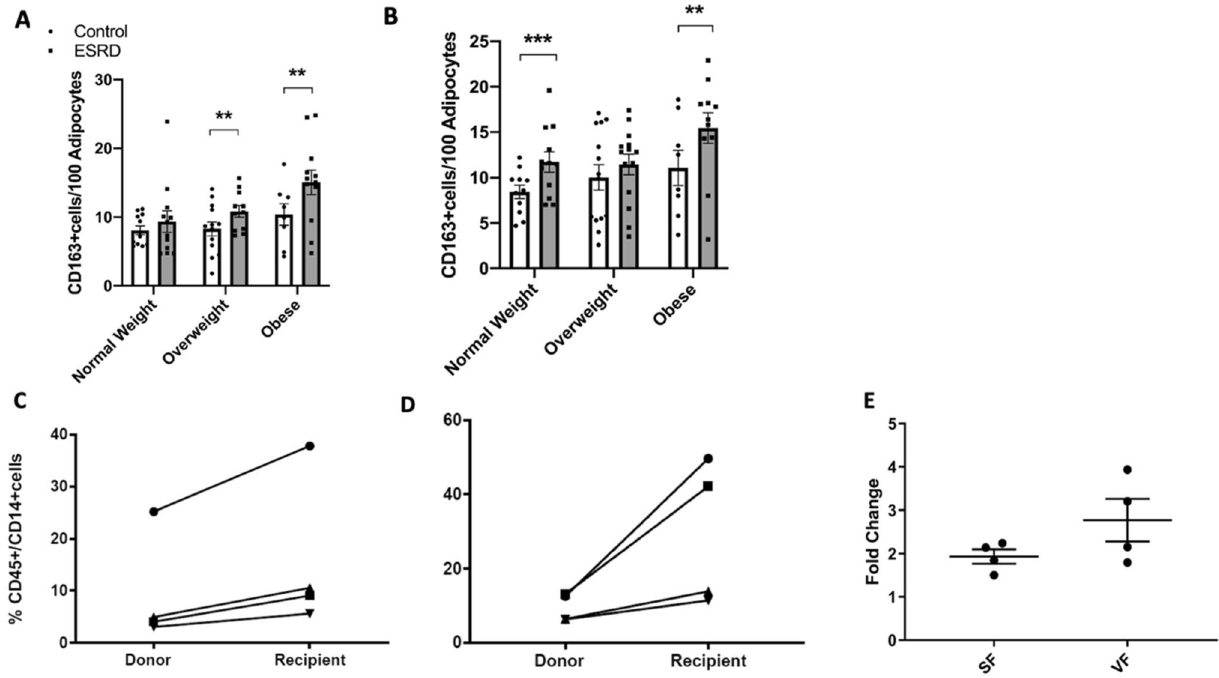
Figure 7. Adipose tissue macrophage counts in uremic patients versus controls stratified by BMI. (A) Mean number of CD163+ cells per 100 adipocytes in subcutaneous adipose tissue. ( B ) Mean number of CD163+ cells per 100 adipocytes in visceral adipose tissue. ( C ) CD45+/CD14+ % cells (macrophages) in subcutaneous adipose tissue of kidney donors compared to kidney transplant recipients (n = 4 per group). ( D ) CD45+/ CD14+ % cells in visceral adipose tissue (of kidney donors compared to kidney transplant recipients. Lines link participant pairs (donor and recipients) that were analyzed on the same day ( E ) Macrophage fold change between donors and recipients in subcutaneous versus visceral fat. Mann–Whitney U test, error bars represent IQR. *p ≤ 0.05. SF, subcutaneous fat. VF, visceral fat. ESRD, end stage renal